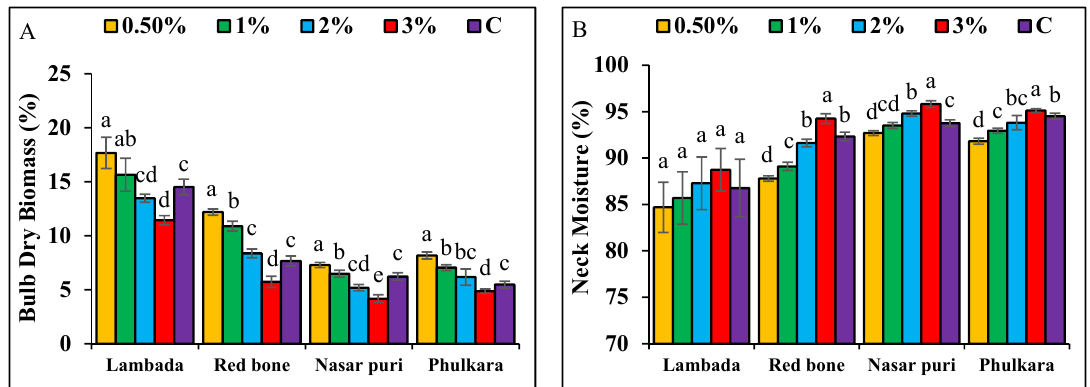
Figure 5. Bulb dry biomass ( A ) and neck moisture ( B ) in onion cultivars as affected by foliar application of 0 (C = control), 0.5, 1, 2, or 3% seaweed extract. Values are means of nine replicates ± standard error. Means with different letters are significantly different from each other compared by LSD at p ≤ 0.05.